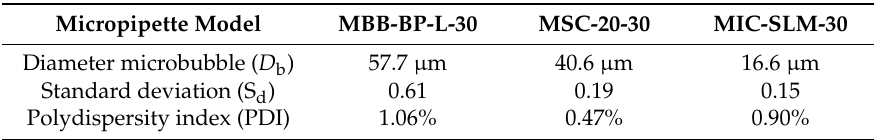
Table 2. Results obtained using the various micropipettes.